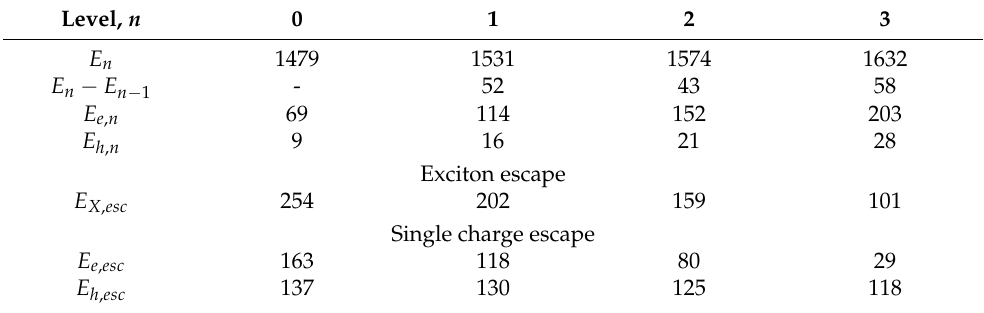
Table 1. Measured PL energies E n for QD sample type III at T R = 300K. Calculated electron and hole quantization energies and escape energies. All energy values are in meV.